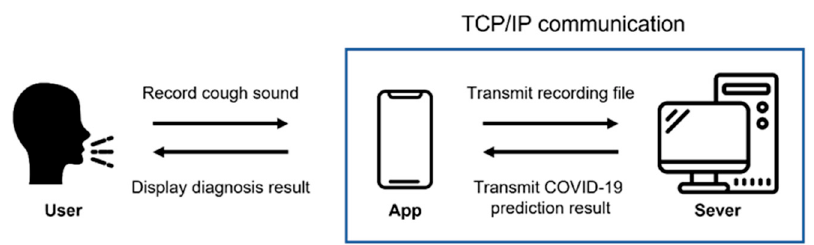
Figure 5. Execution process of the application.